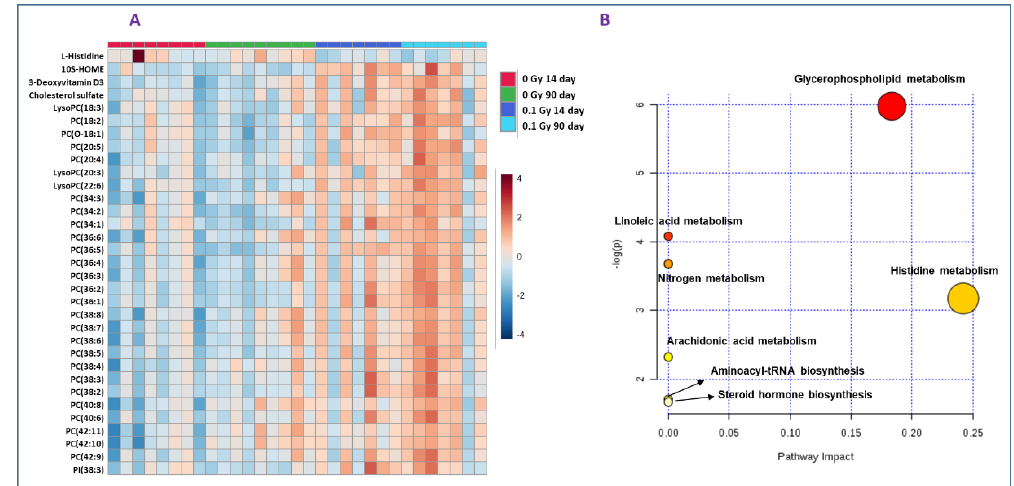
Figure 3. Dysregulated metabolites and biochemical pathways of low dose high-LET radiation. Panel ( A ): Hierarchical clustering analysis of differential metabolite expression in the irradiated and sham groups. Panels ( B ): Pathway analysis of differentially abundant metabolites identified in plasma from mice exposed to 0.1 Gy 16 O compared to sham using MetaboAnalyst 3.0.